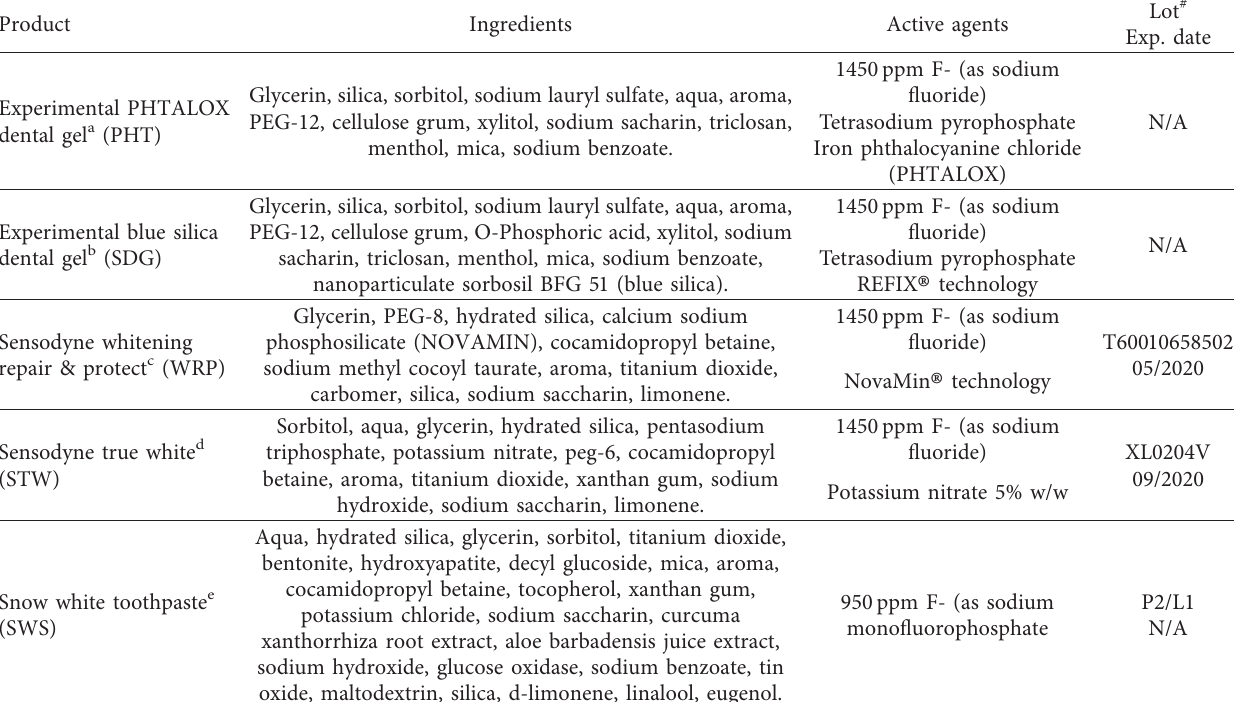
Table 1: Composition of the toothpastes selected for the study ∗